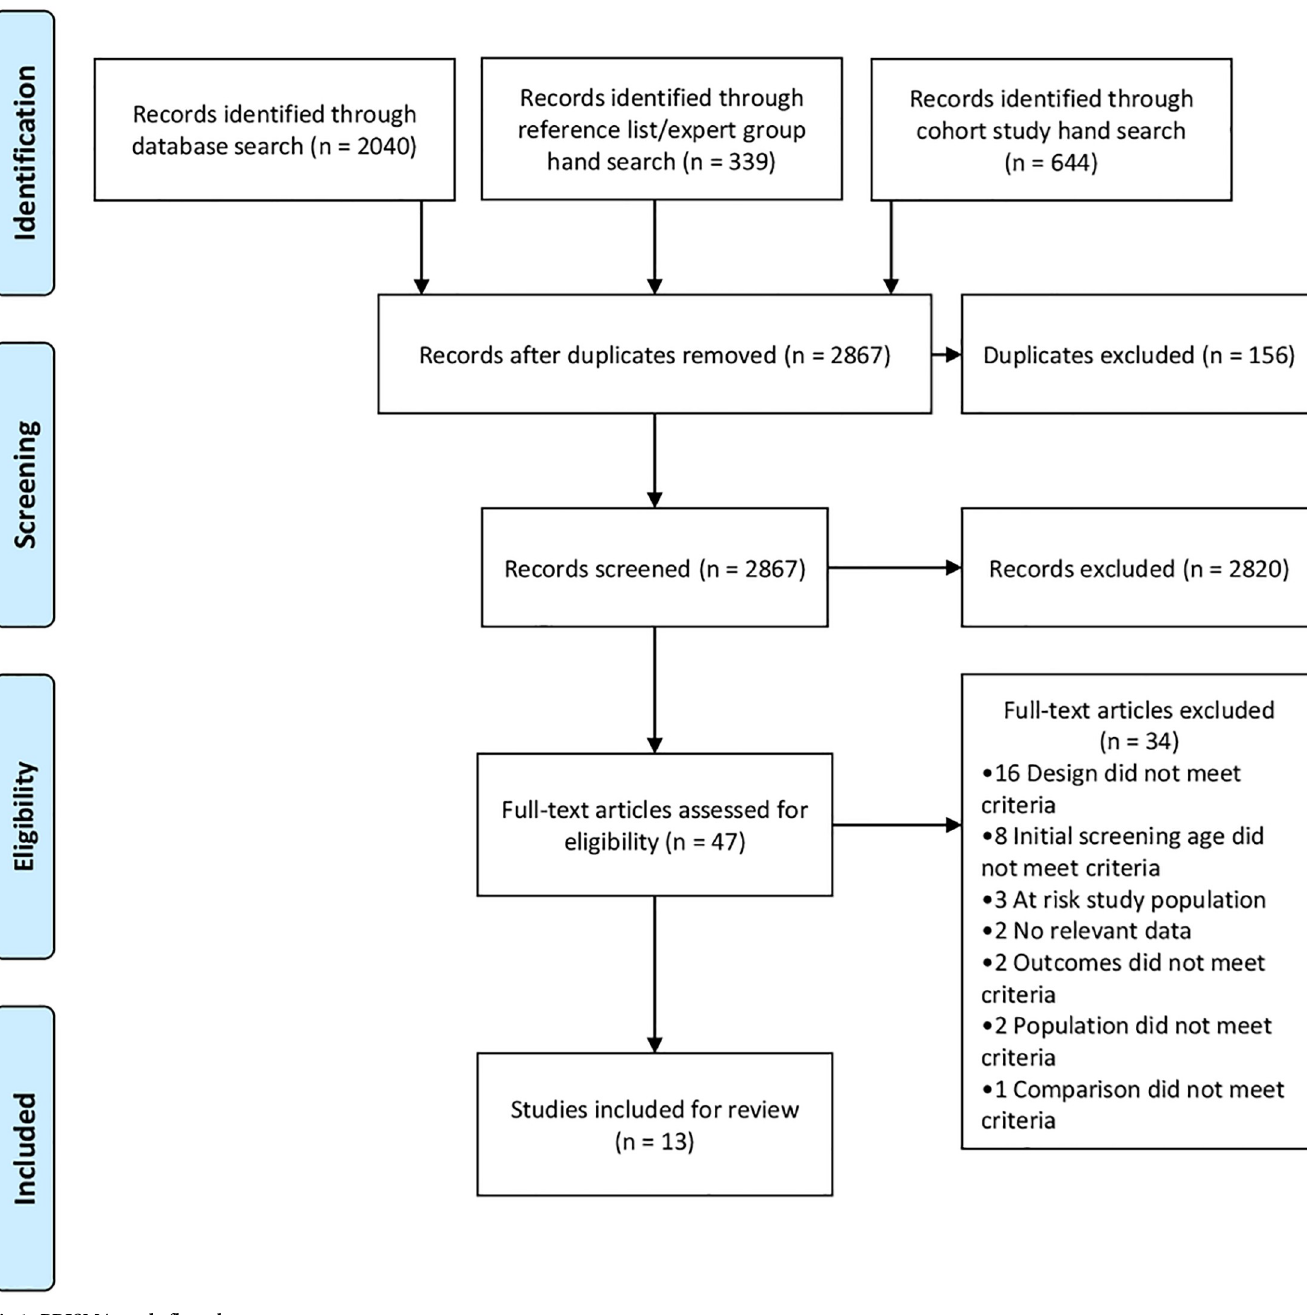
Fig 1. PRISMA study flow